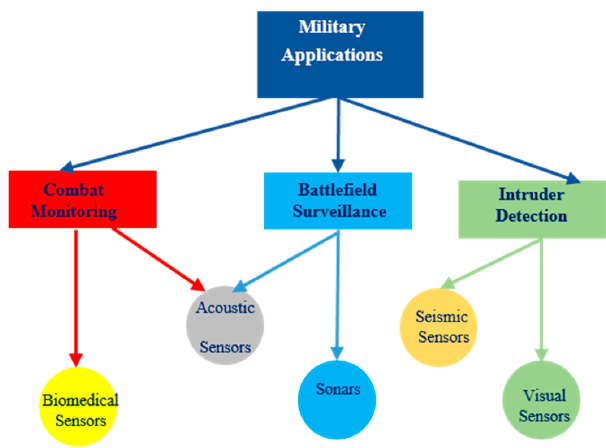
Figure 4. The subcategories of the military applications of WSNs and the types of sensors they use.